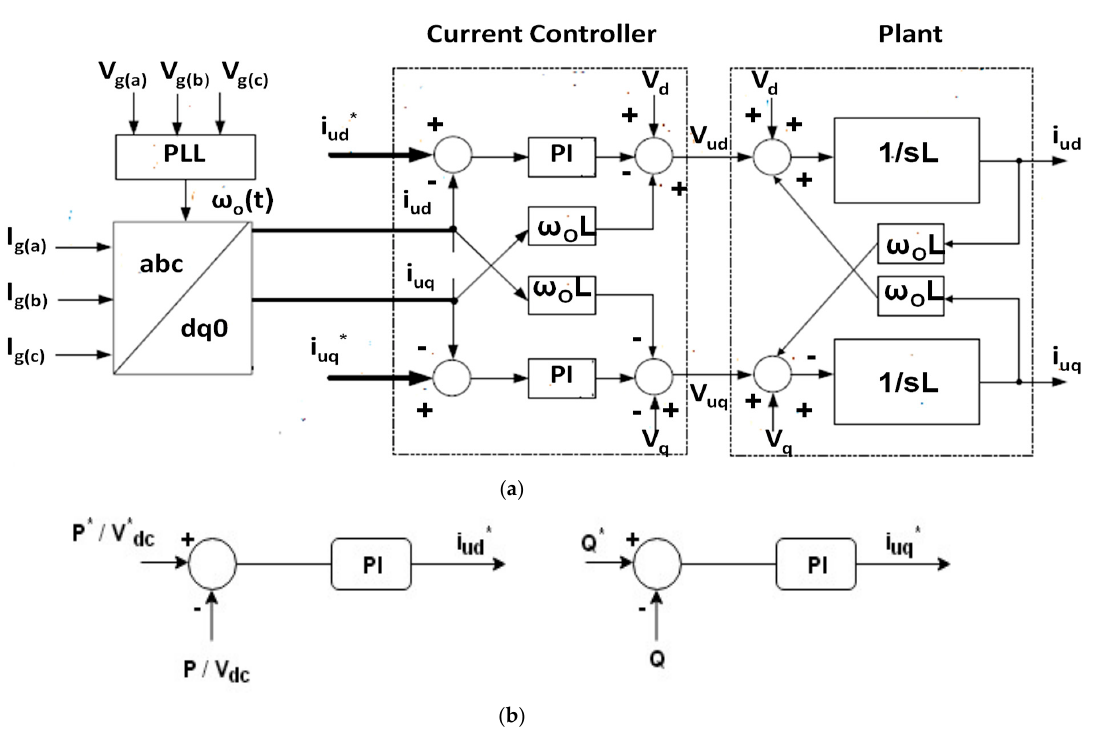
Figure 2. ( a ) Inner current control; ( b ) Outer loop power and